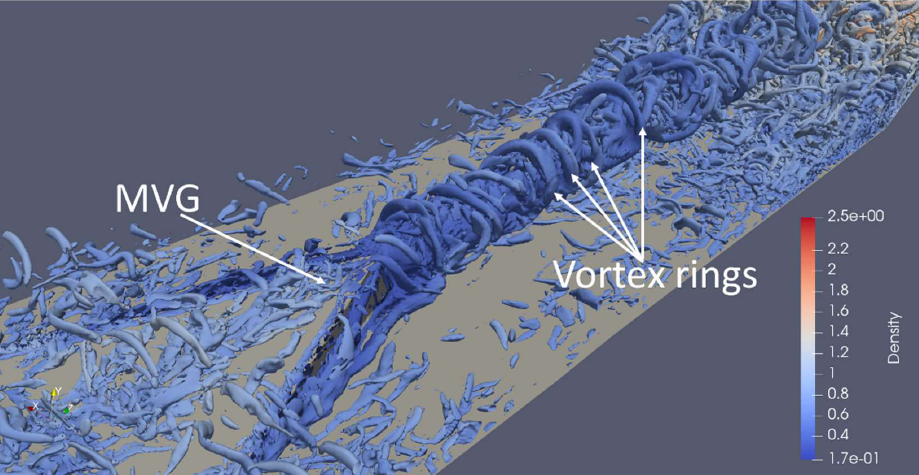
Fluids 2022 , 7 , x FOR PEER REVIEW Figure 4. A sequence of vortex rings is generated behind MVG. Figure 4. A sequence of vortex rings is generated behind MVG.